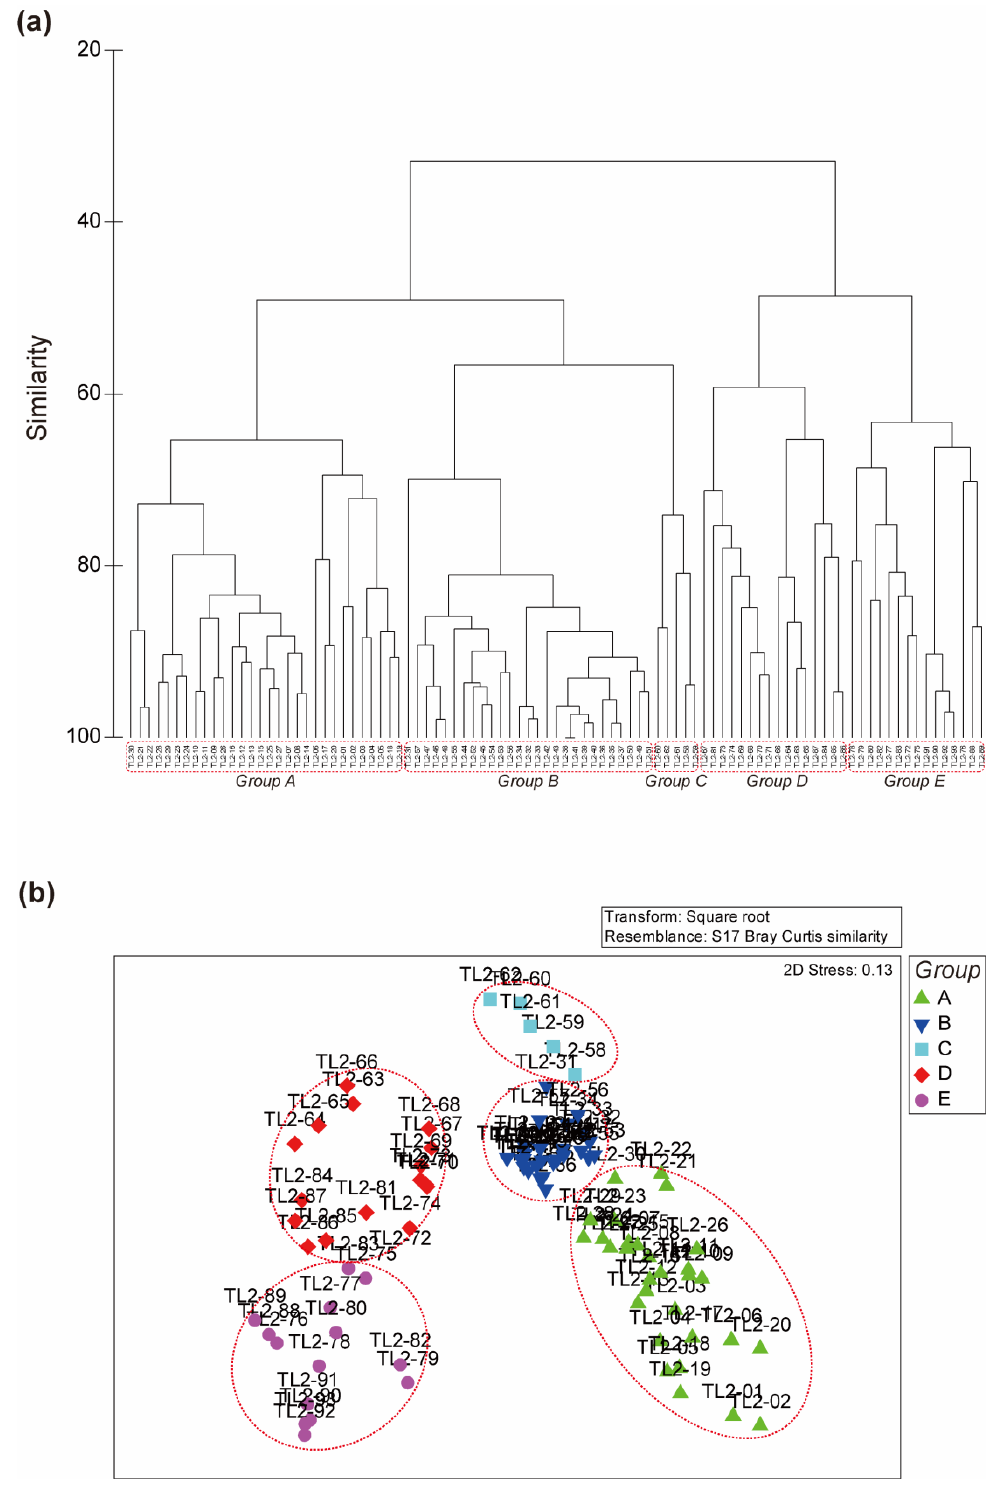
Figure 8. Multivariate analyses of the second transect (TL-2). ( a ) Dendrogram of cluster analysis. ( b ) Non-metric multidimensional scaling ordination results. Analyses based on square root trans- formed coverage data of benthic habitat types as determined by digital imaging analysis of the 93 photo-quadrats (i.e., sampling points) along TL-2.